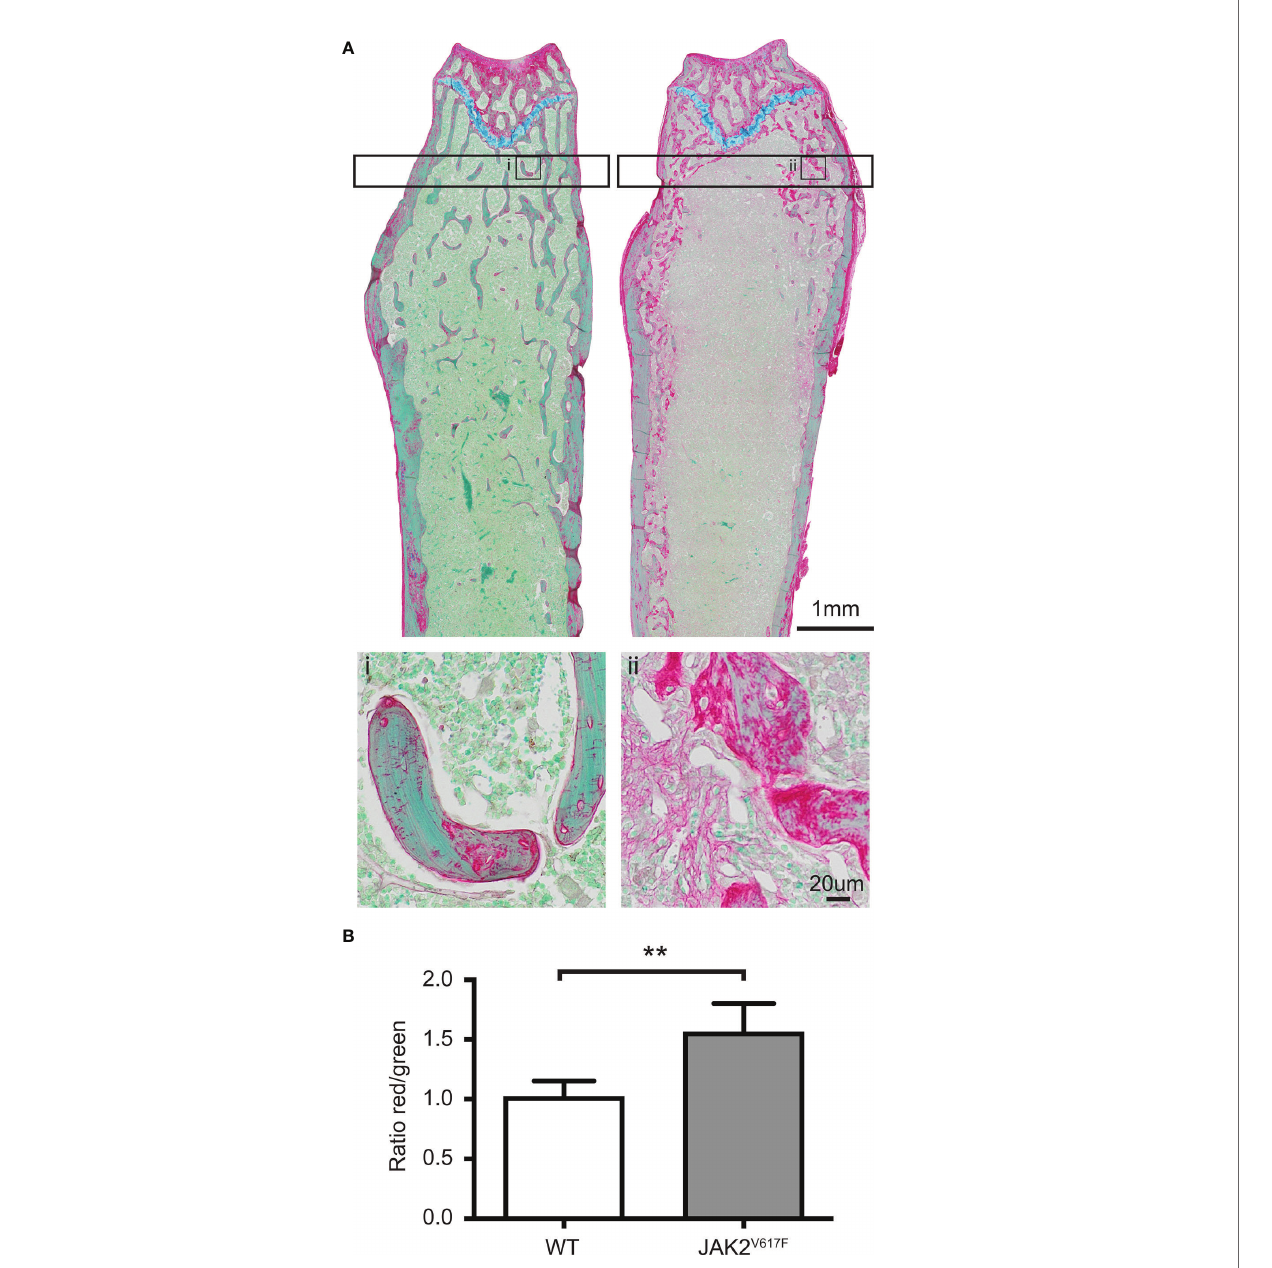
FIGURE 2 | RGB trichrome staining of femurs. Femurs of JAK2 V617F male mice and matching controls were stained with picrosirius Red, fast Green and alcian Blue, providing discrimination between mineralized and unmineralized (osteoid) bone. (A) Representative images of bone sections of WT mice (denoted as i) and JAK2 V617F (denoted as ii). Osteoid appears red, mineralized bone appears green and cartilage appears blue. The lower part of Panel A shows a magni fi cation of an inset in the upper part of the panel. (B) Quantitative analysis of the ratio osteoid (red)/mineralized bone (green) for trabecular bone. Measurements are presented as mean ± SD. The analysis of the trabecular bone was conducted 50 m m distant from the edge of the growth plate, extending 300 m m. Four JAK2 V617F and four WT 30 weeks old male mice were analyzed. **Denotes